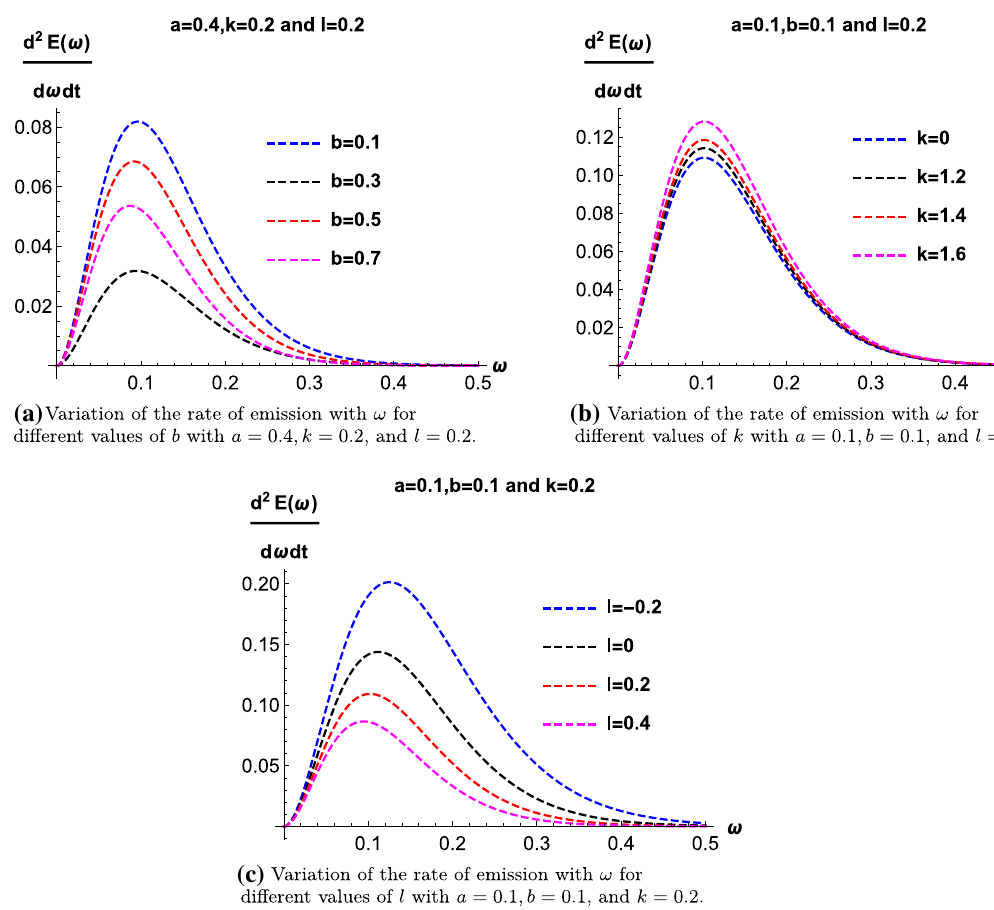
Fig. 16 Variation of the rate of emission with ω for different situations